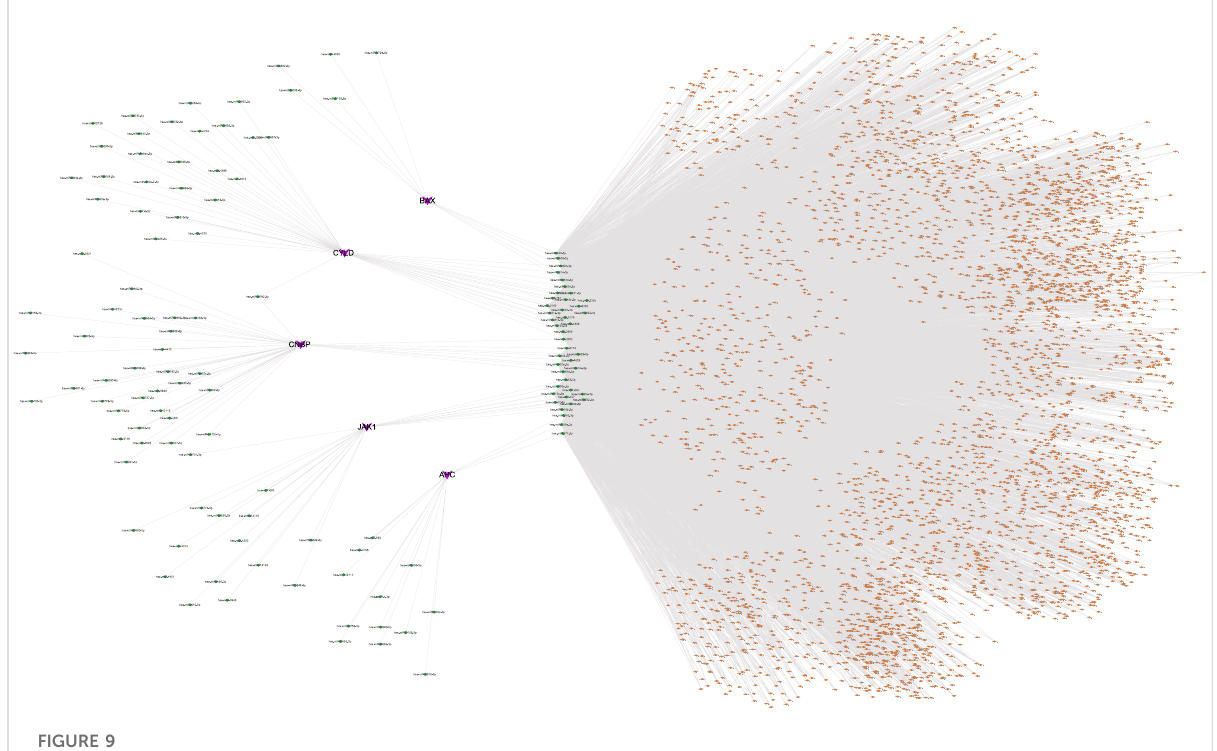
FIGURE 9 Model gene-related ceRNA network, purple represents mRNA, green represents miRNA, yellow represents lncRNA. Based on miRWalk, TargetScan and miRDB databases, using Cytoscape software